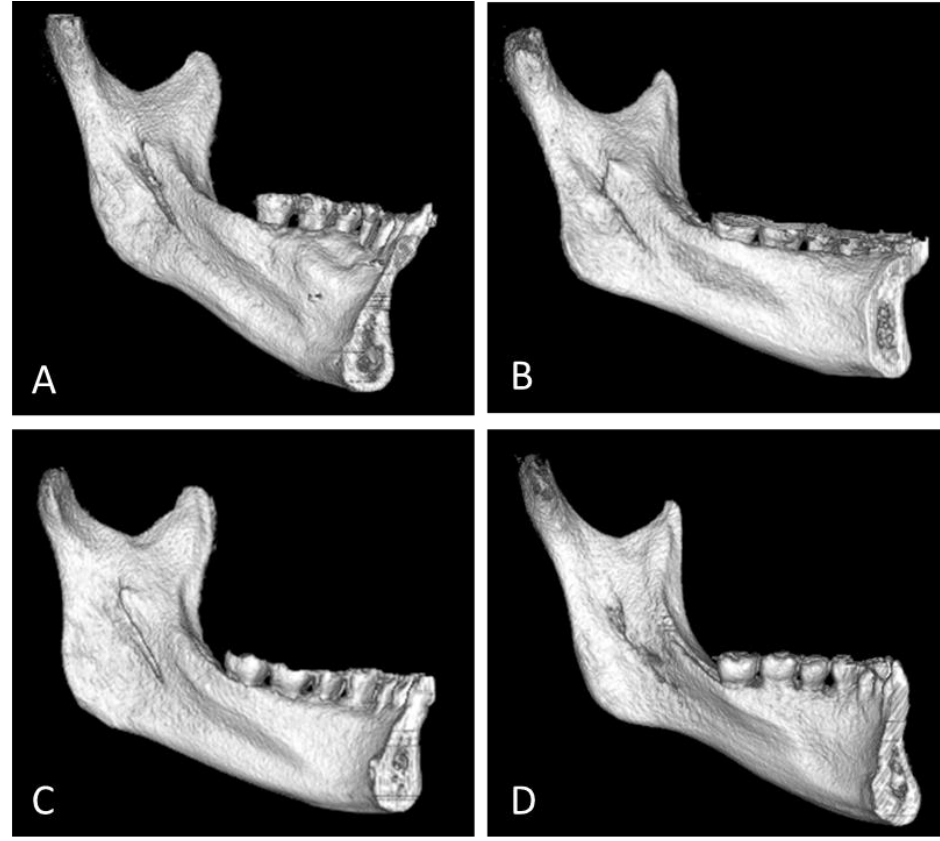
Figure 1. Four types of lingula. ( A ) Nodular ( B ) Truncated ( C ) Triangular ( D ) Assimilated .